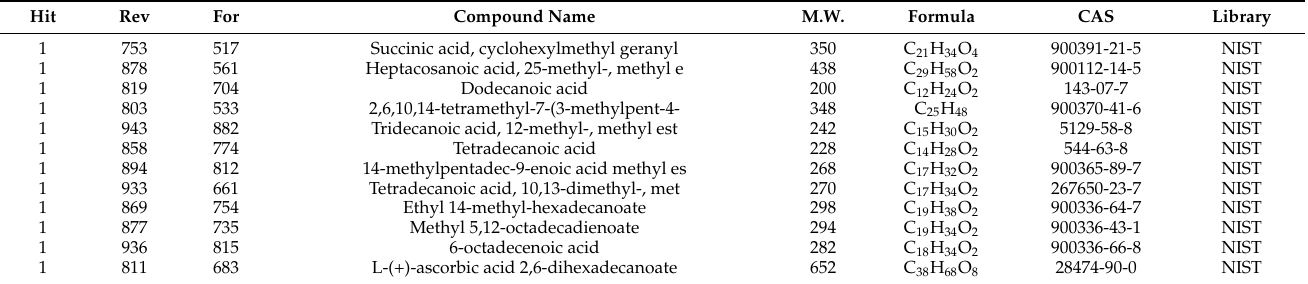
Table 1. Identification of compounds in the peel and kernel M-Ext through GCMS